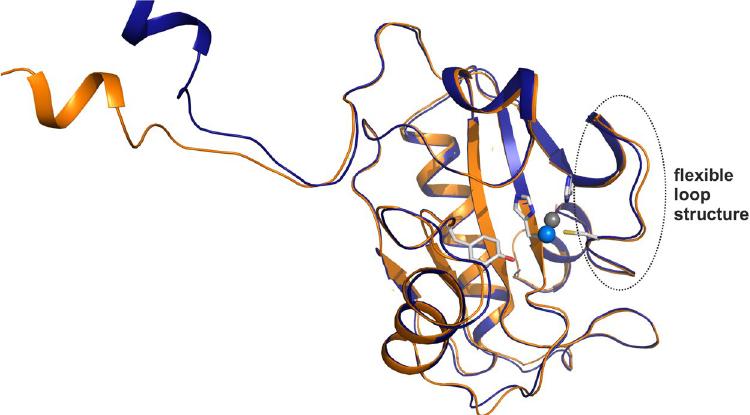
Figure 1. Superposition of the two Ts2631 endolysin monomers in the asymmetric unit. The two independent molecules of Ts2631 endolysin observed in the asymmetric unit superimpose with an r.m.s.d. of 0.6 Å (for residues 16–156; monomers are marked in orange and dark blue). The N-termini of the molecules do not superimpose due to a deviation from perfect non-crystallographic symmetry. The flexible loop structure is indicated by a dotted